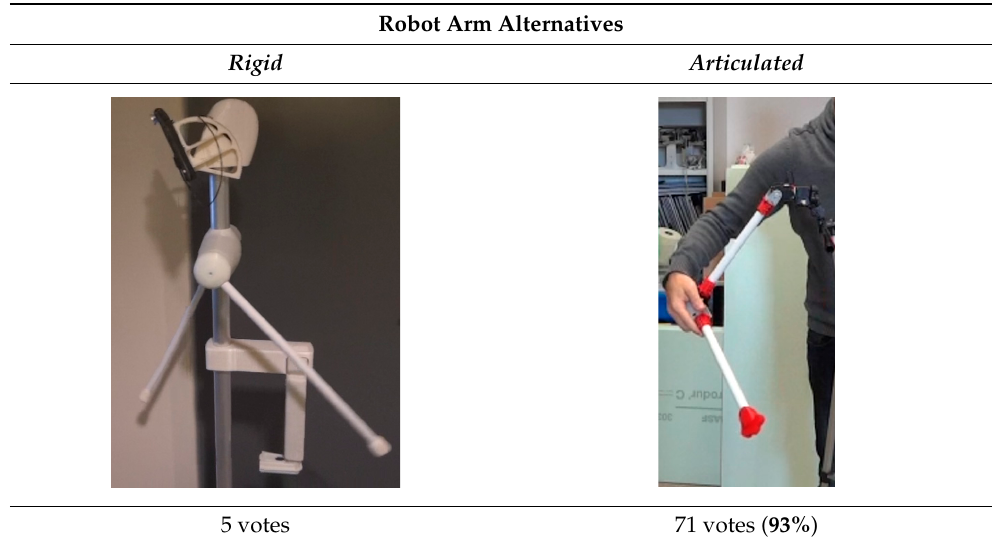
Table 2. Alternatives considered to implement the robot arm and votes received.